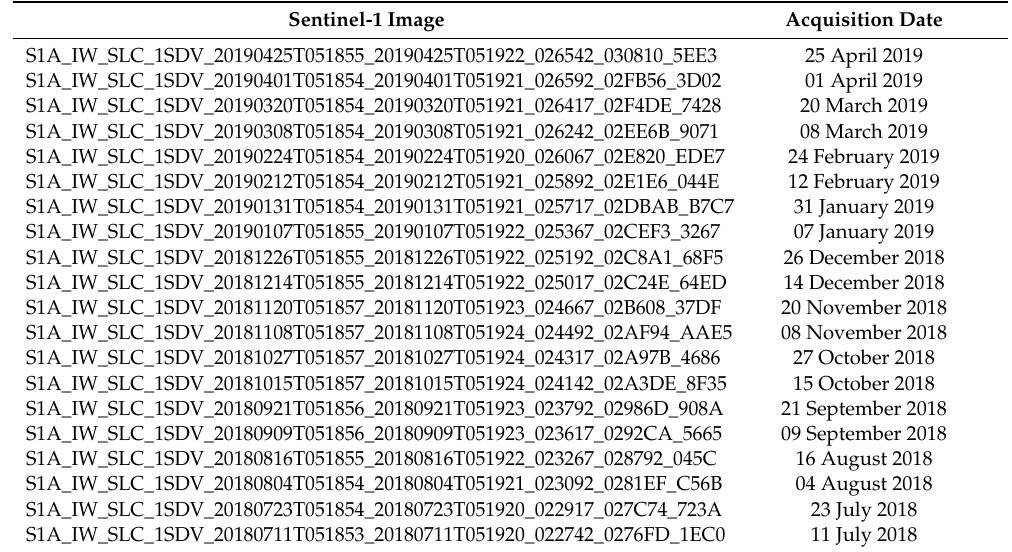
Table 1. All the Sentinel-1 images used in this work. Downloaded from the Sentinel Open Access Hub